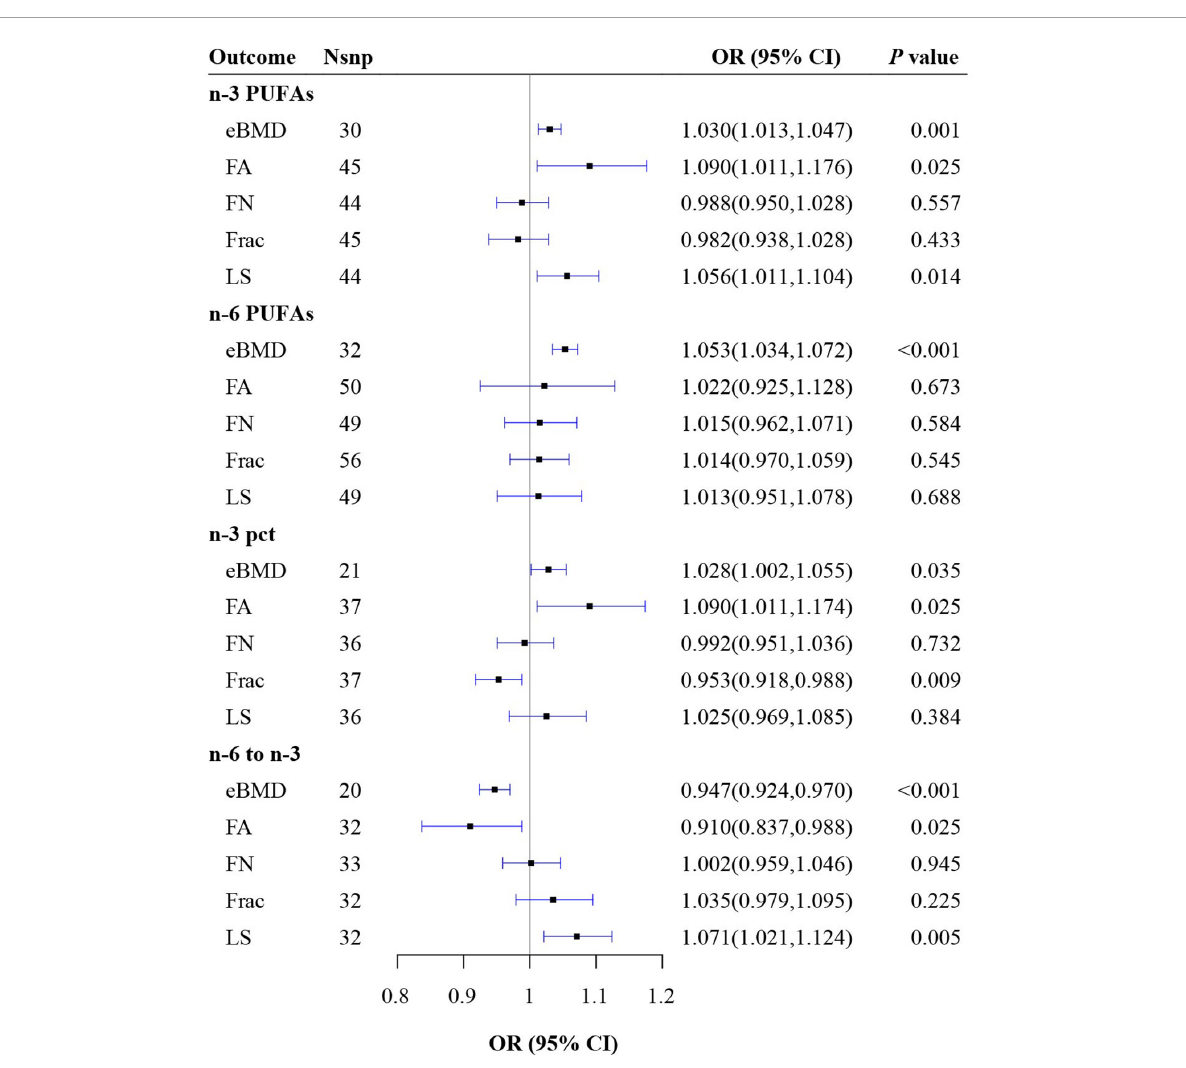
FIGURE1 Mendelian randomization (MR) estimate results of polyunsaturated fatty acids (PUFAs) on outcomes. n-3 pct, the ratio of n-3 fatty acids to total fatty acids; n-6 to n-3, the ratio of n-6 PUFAs to n-3 PUFAs; BMD, bone mineral density; eBMD, estimated BMD; FA, forearm; FN, femoral neck; LS,